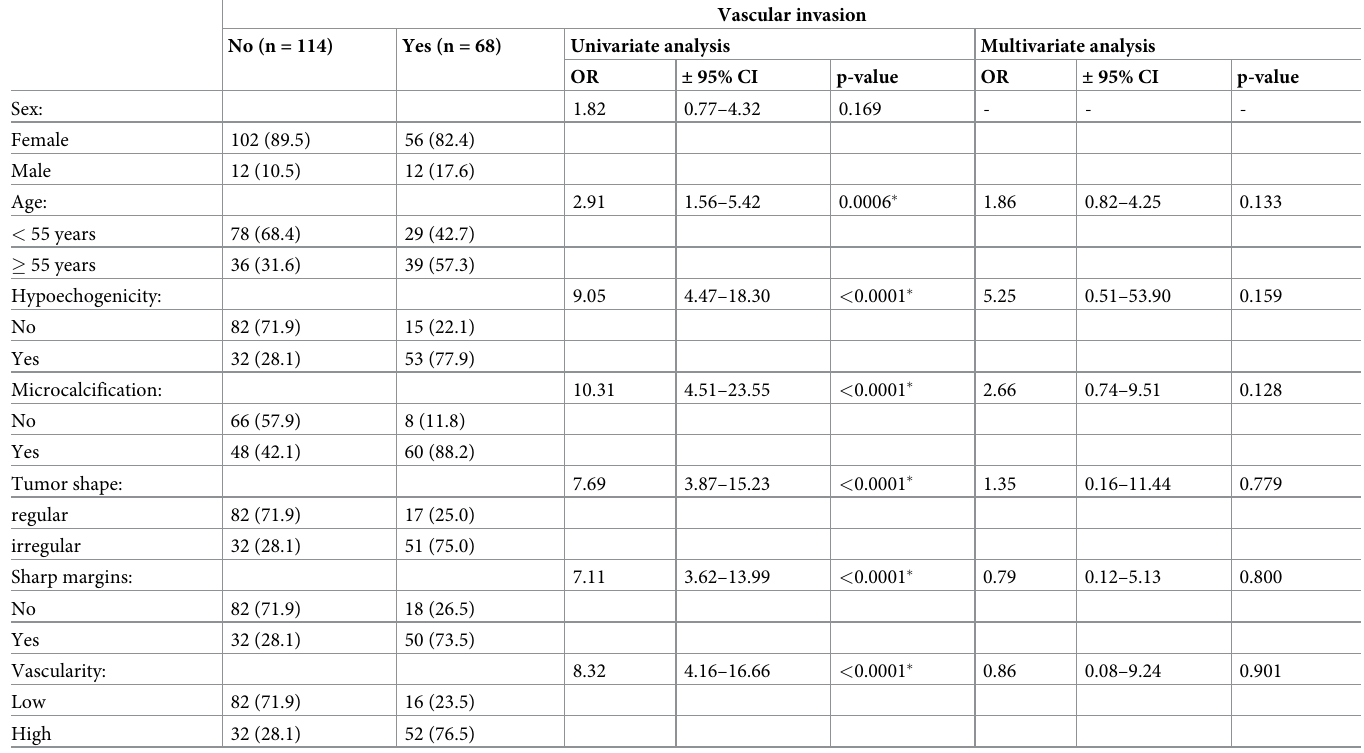
Table 4. Univariate and multivariate logistic regression analysis of demographic and ultrasound features as risk factors for vascular invasion in PTMC